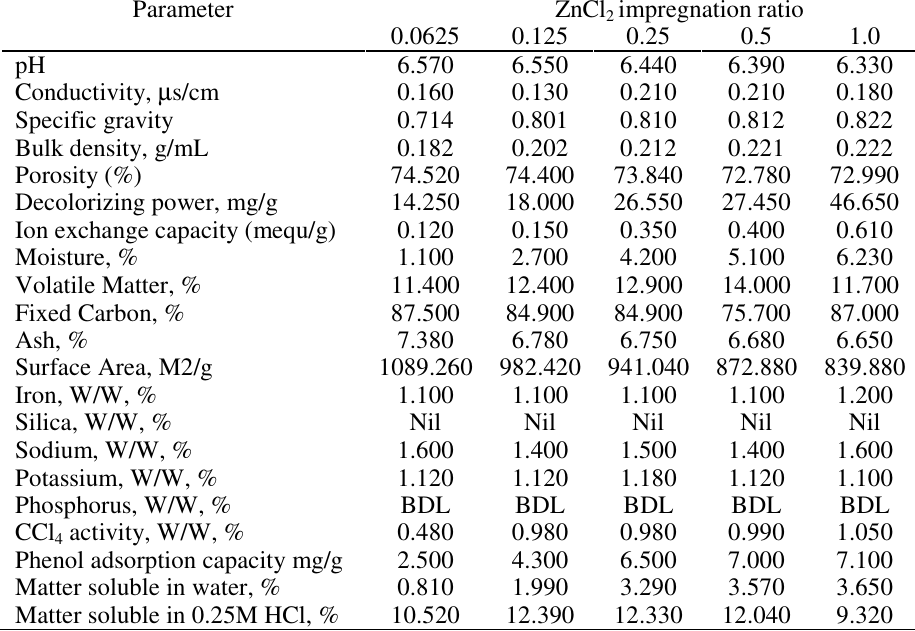
Table 4 . Characteristics of Parthenium activated carbon prepared by chemical activation (ZnCl 2